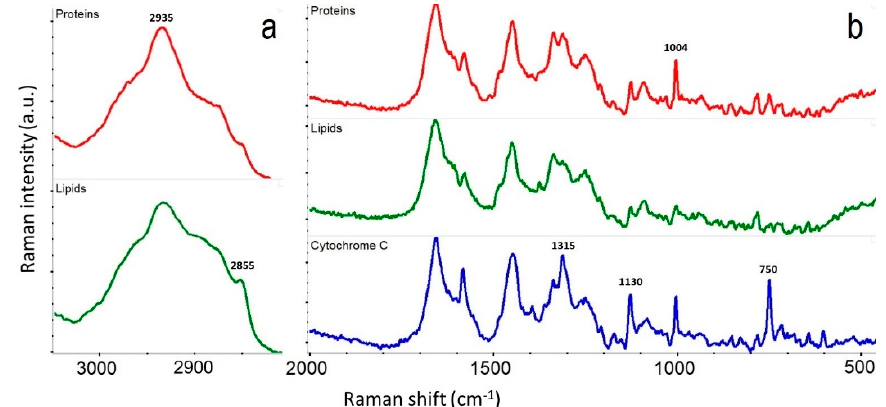
Figure 9. Representative average Raman spectra assigned to the locations of proteins, lipids, and cytochrome C in the live HEK cells shown in Figure 8: ( a ) the spectral region of the CH x stretch vibrations of the hydrocarbon chains with the marked peaks at 2935 and 2855 cm − 1 associated with proteins and lipids, respectively; ( b ) the “fingerprint” region with the marked peaks at 1004 cm − 1 assigned to phenylalanine (Phe) typical for proteins, and the resonantly enhanced peaks at 1315, 1130, and 750 cm − 1 in the cytochrome C.